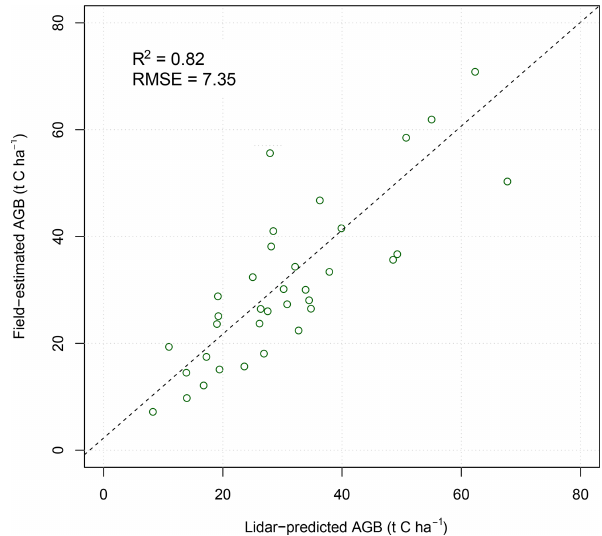
Figure 3. Relationship between field-estimated above-ground biomass and estimates predicted from airborne lidar metrics. Open green circles represent individual subplots (30m × 30m); the dashed line shows the linear